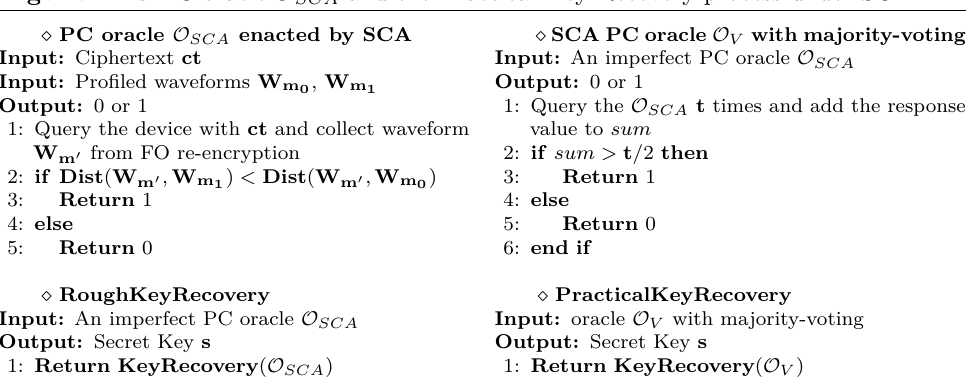
Algorithm 3 PC oracle O SCA and the Practical Key Recovery process under